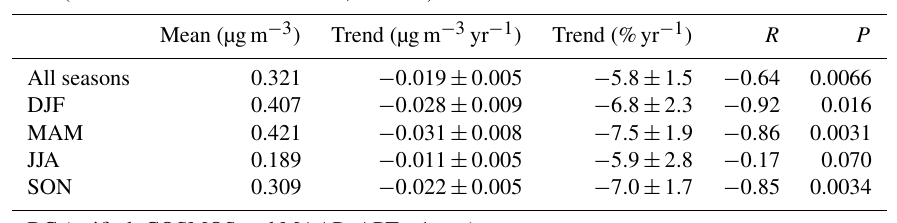
Table 1. Observed trends in atmospheric black carbon (BC) mass concentrations at Fukue Island for 2009–2019 and showing cases with and without data filtering based on the accumulated precipitation along trajectory (APT) criterion for all seasons and in each season. The BC mass concentrations are those unified from a continuous soot monitoring system (COSMOS) and a Multi-Angle Absorption Photometer